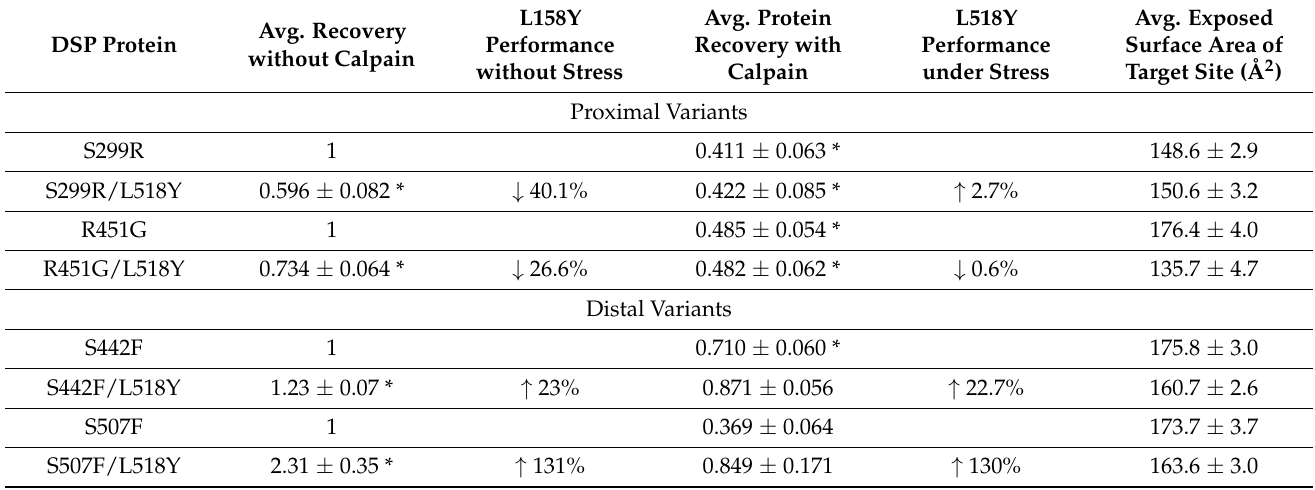
Table 1. L518Y DSP point mutation results in moderate protection from degradation by calpain and decreased surface area of the calpain target site. Average recovery of DSP variants after incubation at 37 ◦ C for 30 min with and without calpain. Performance of the secondary L518Y mutation was calculated by measuring the percent change compared to its single mutant counterpart. The corresponding solvent-exposed surface area of the calpain target site (447–451) for each variant is also shown. * p < 0.05 compared to clinical variant without